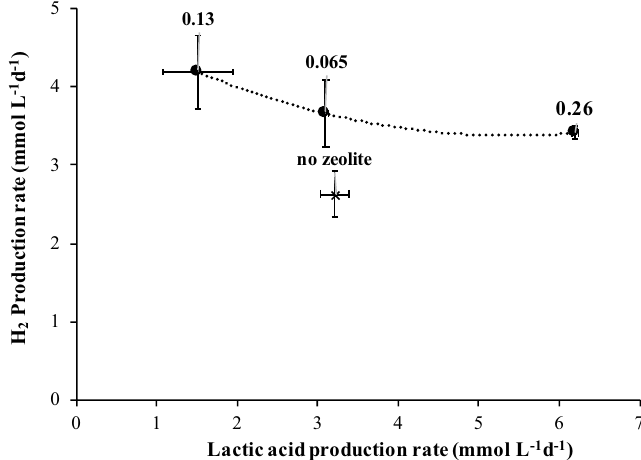
Figure 6. Rates of hydrogen and lactate production for the experiments Numbers represent the Z/I ratio.